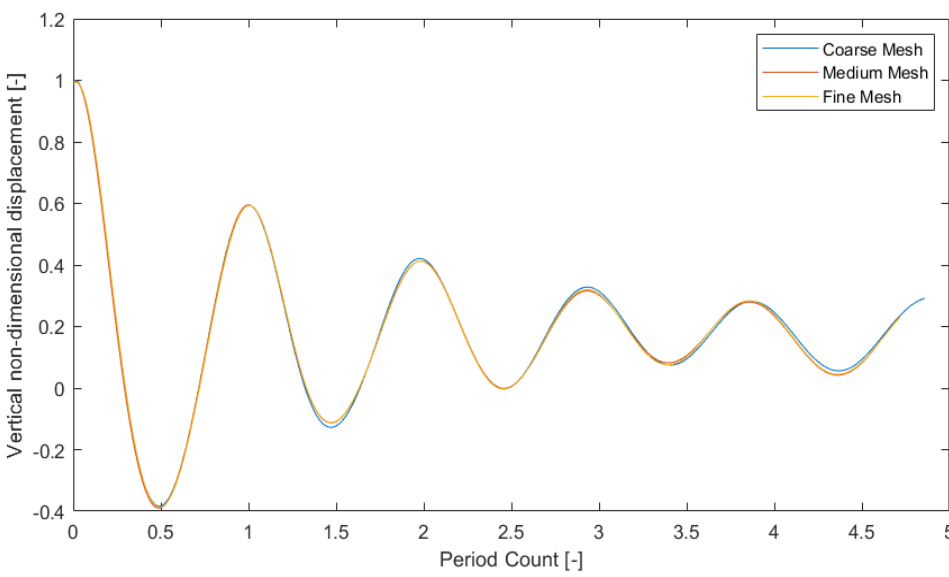
Figure 2. Direct comparison of the signals obtained in the mesh sensitivity study.